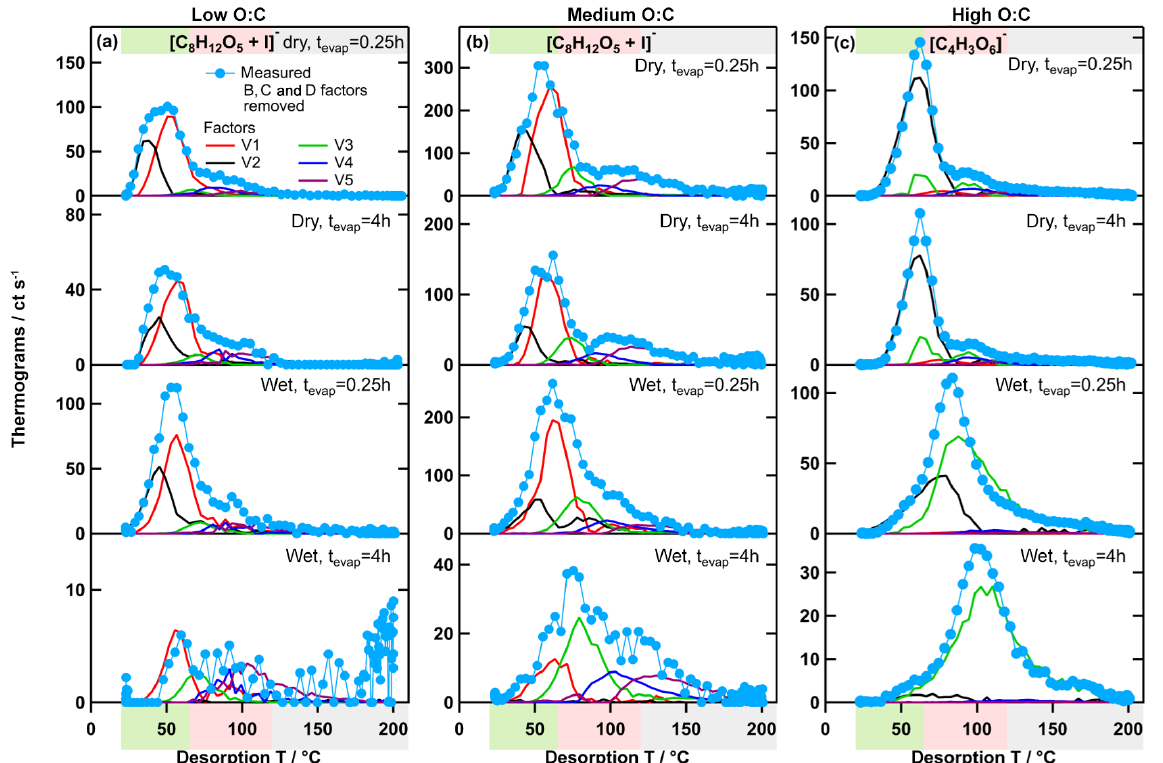
Figure 9. Measured ion thermograms and factor thermograms for ion [C 8 H 12 O 5 + I] − in the low- (a) and medium-O : C cases (b) and C 4 H 3 O − in the high-O : C case (c) . Note that the contributions of the type-B, type-C, and type-D factors were subtracted from the measured 6 ion thermograms to enhance comparability between the measured data and the PMF